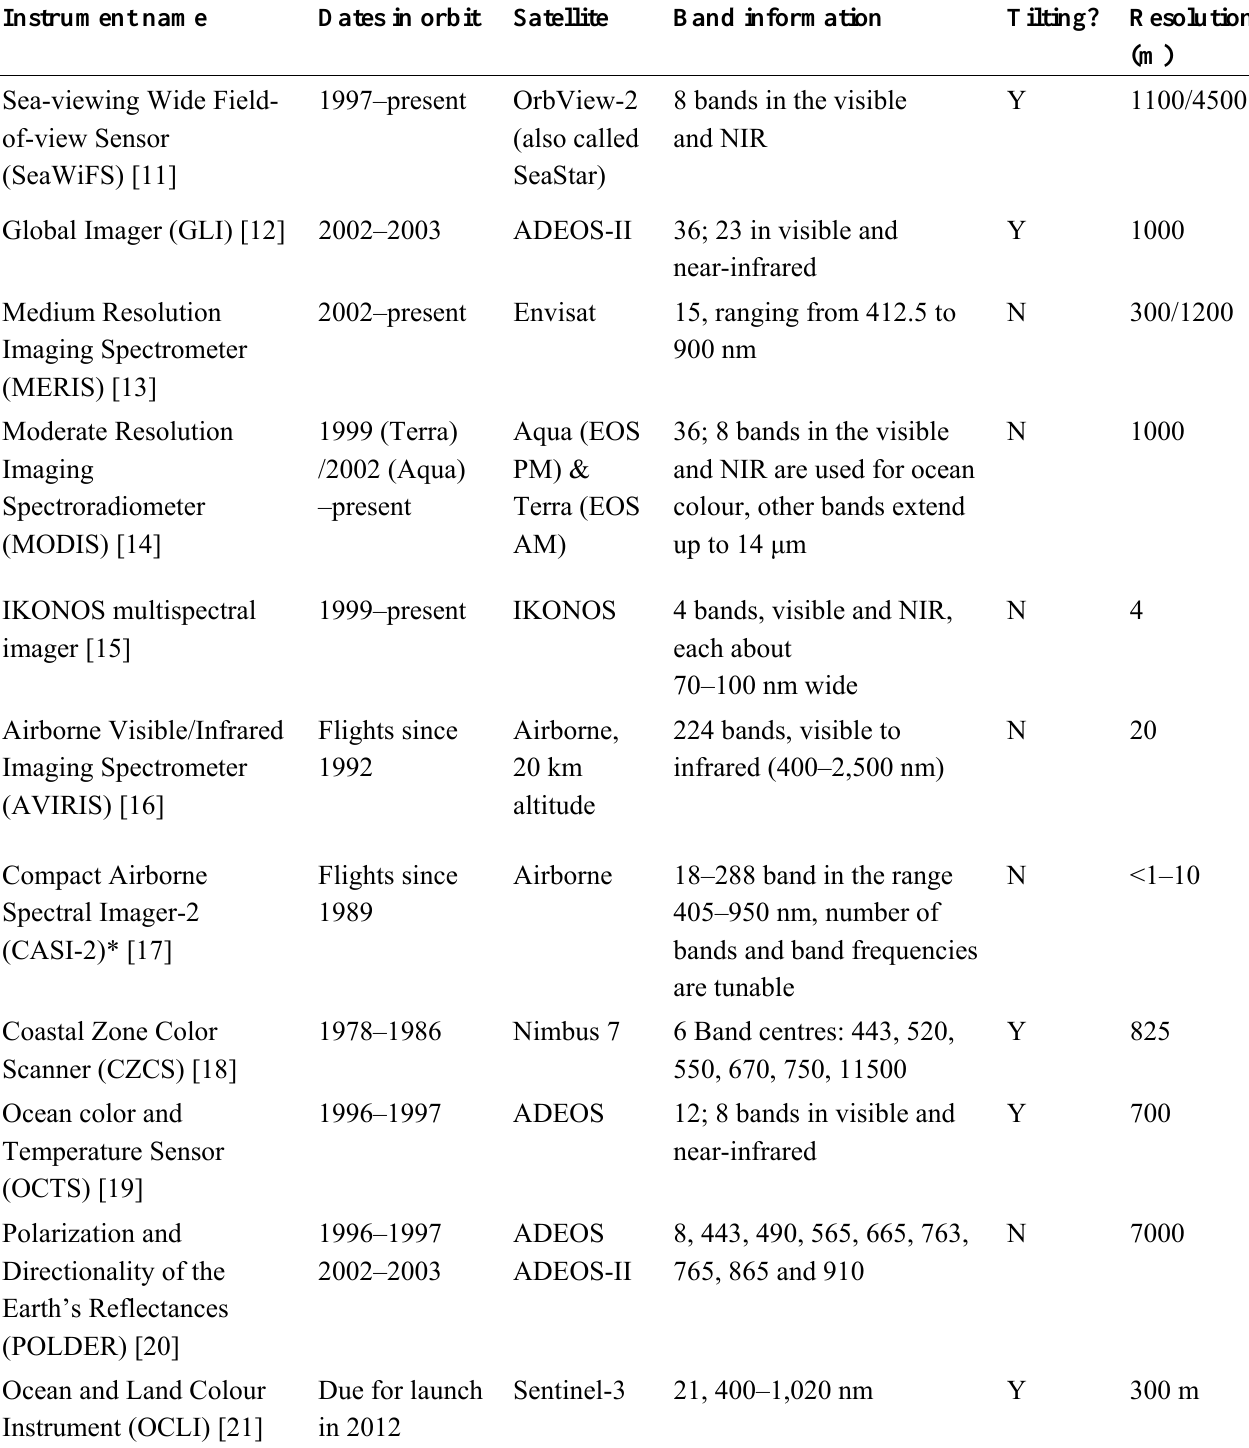
Table 1. Summary of radiometry instruments mentioned in this